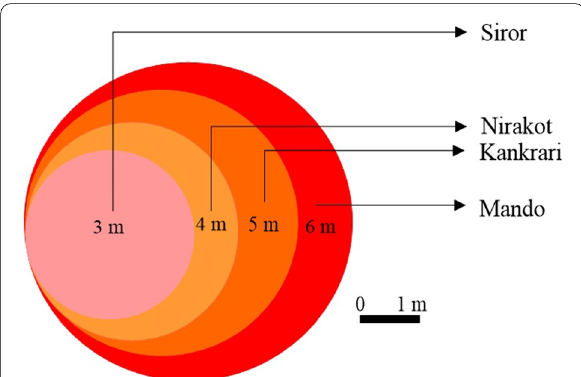
Fig. 6 Village-wise average diameter of